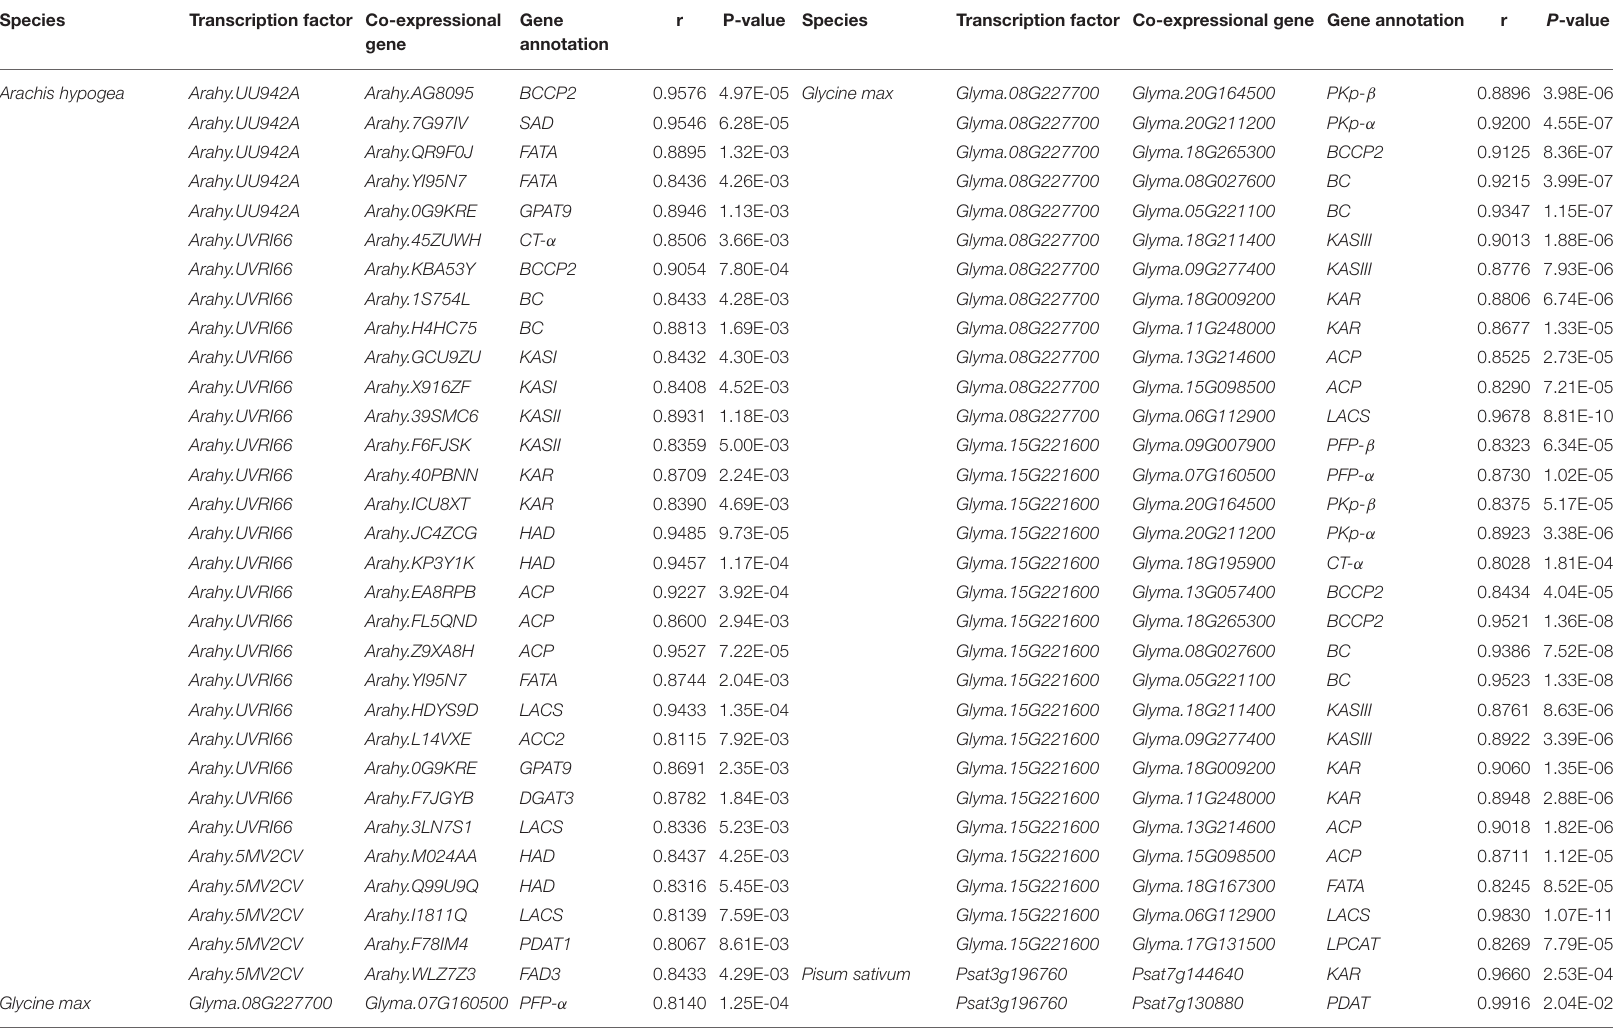
TABLE 2 | Co-expressional gene pairs of WRI1 with oil synthesis genes in peanut, soybean, and